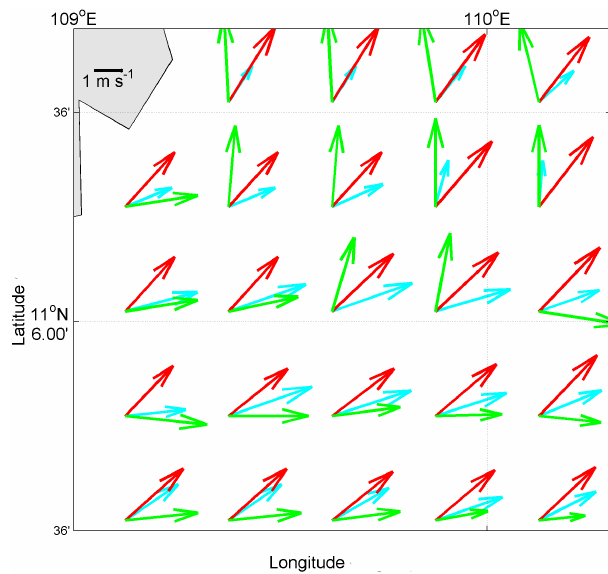
Figure 6. Wind fields on 2 July 2008 (blue arrows), 12 July 2008 (red arrows) and 26 July 2008 (green